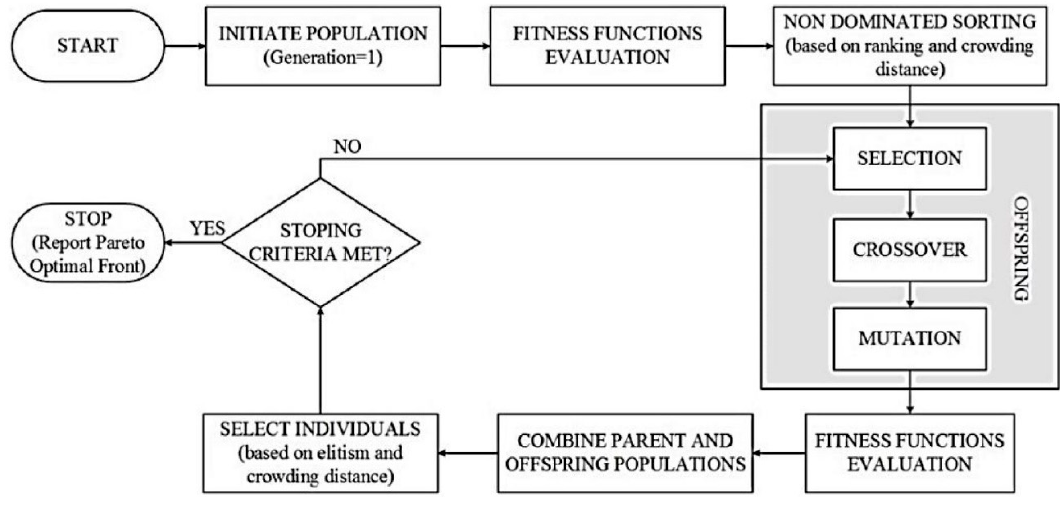
Figure 1. Flowchart of the NSGA-II optimization algorithm [35]. Table 1. NSGA-II parameters for optimization.